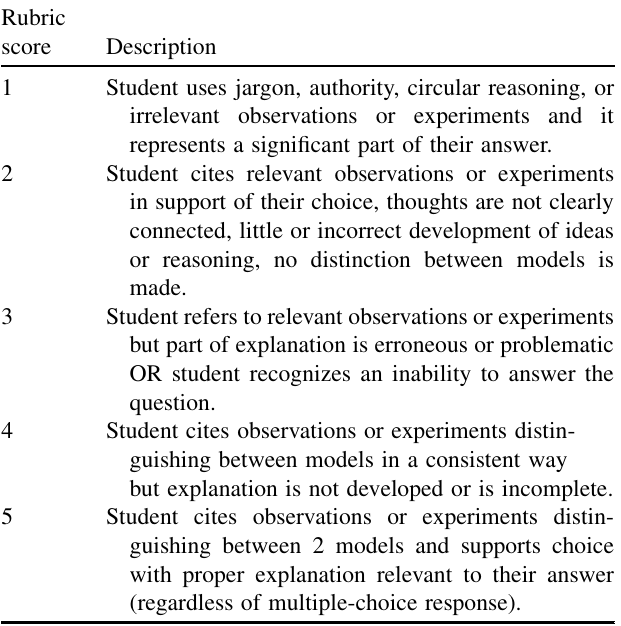
TABLE I. Rubric used to evaluate responses to scientific argu- ment question in Fig. 1.